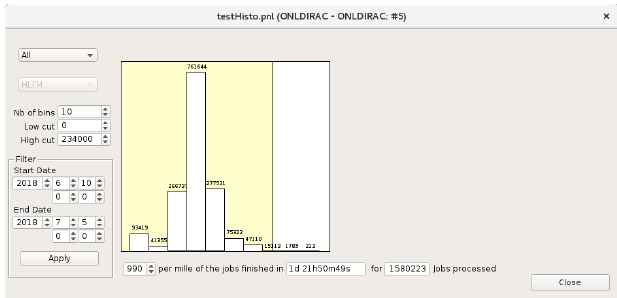
Figure 5. Number of jobs and their average duration ran on the whole LHCb HLT servers during o ffl ine simulation.